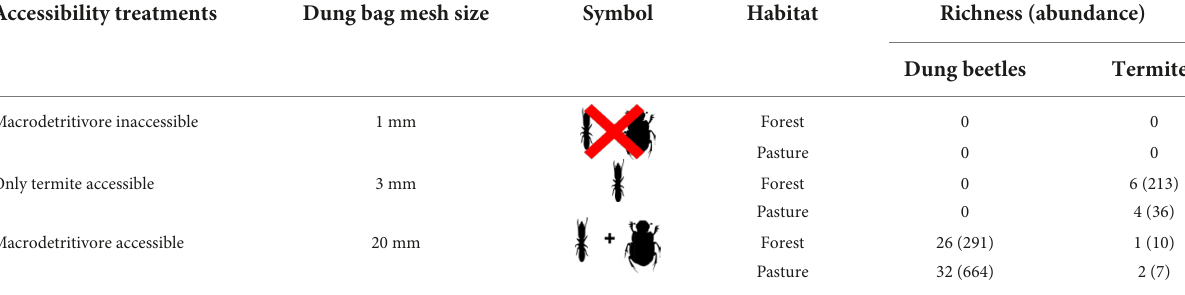
TABLE 1 Richness and overall abundance of dung beetles and termites for the different treatments and habitat types. Accessibility